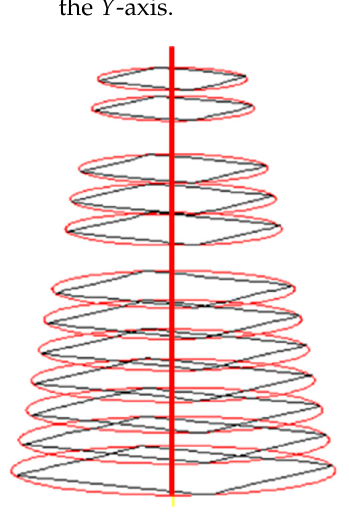
Figure 9. Central axis.